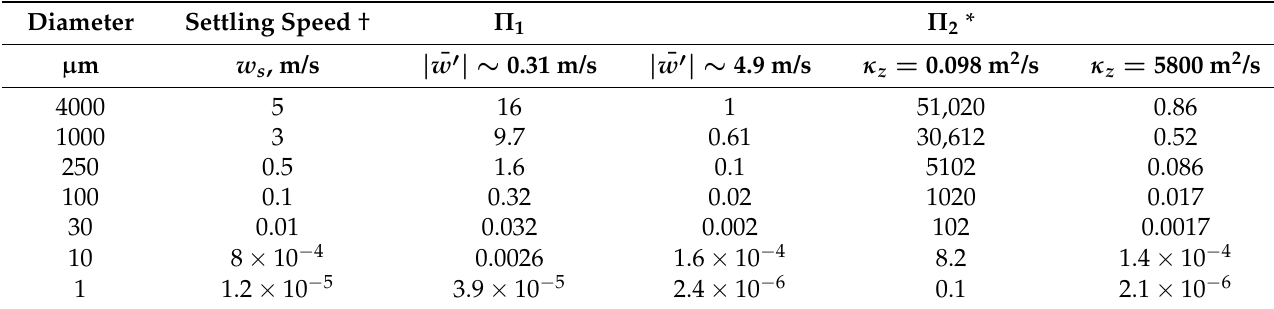
Table 3. Values of dimensionless groups for different particle sizes and layer thicknesses. Note that the boundary between Π Π 2 and unity tends to fall in 10–250 µ m particle size 1 or